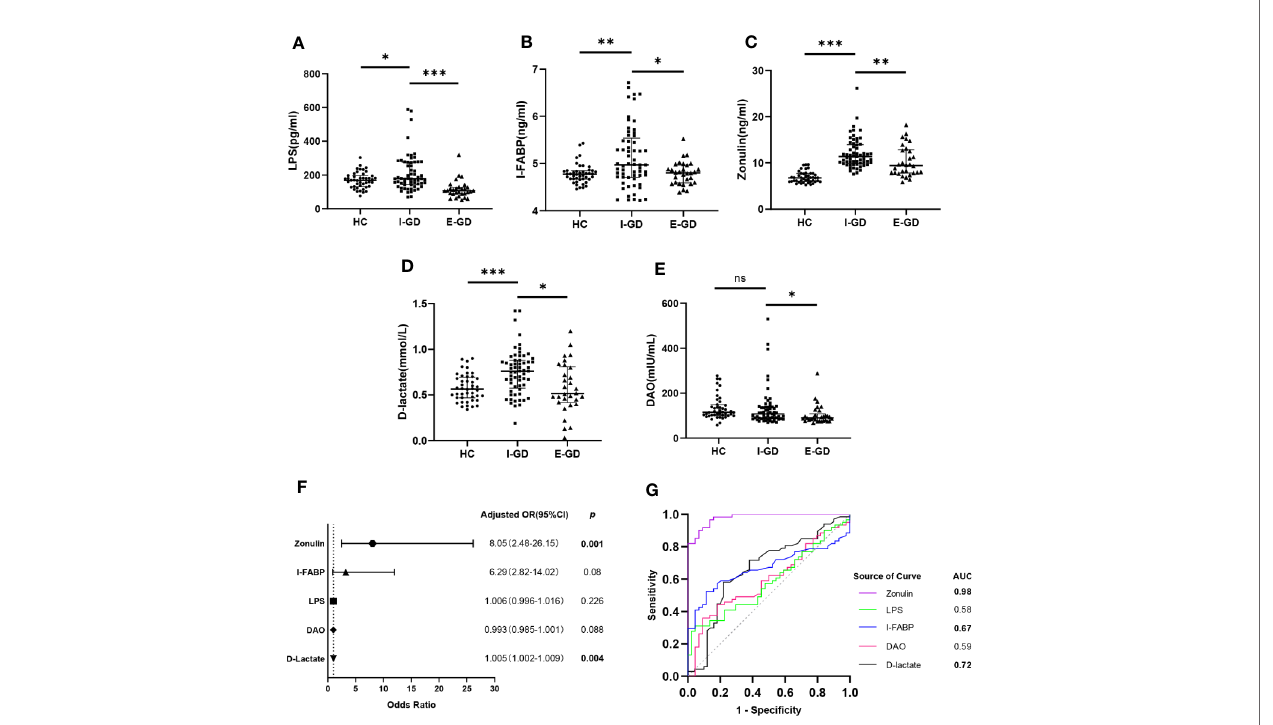
FIGURE 1 | Increased intestinal permeability independently associated with risk for GD and zonulin as a biomarker for the diagnosis of GD. Comparison of serum levels of LPS (A) , I-FABP (B), zonulin (C) , D-lactate (D) and DAO (E) between HC and GD; (F) Forest plot of circulating leaky gut biomarkers associated with GD risk; (G) ROC analysis of circulating leaky gut biomarkers for GD diagnosis; Bars represent the mean ± SD. * p < 0.05; ** p < 0.01; *** p < 0.001; LPS, lipopolysaccharides; I-FABP, intestinal fatty acid binding protein; DAO, diamine oxidase; HC, healthy controls; GD, Graves ’